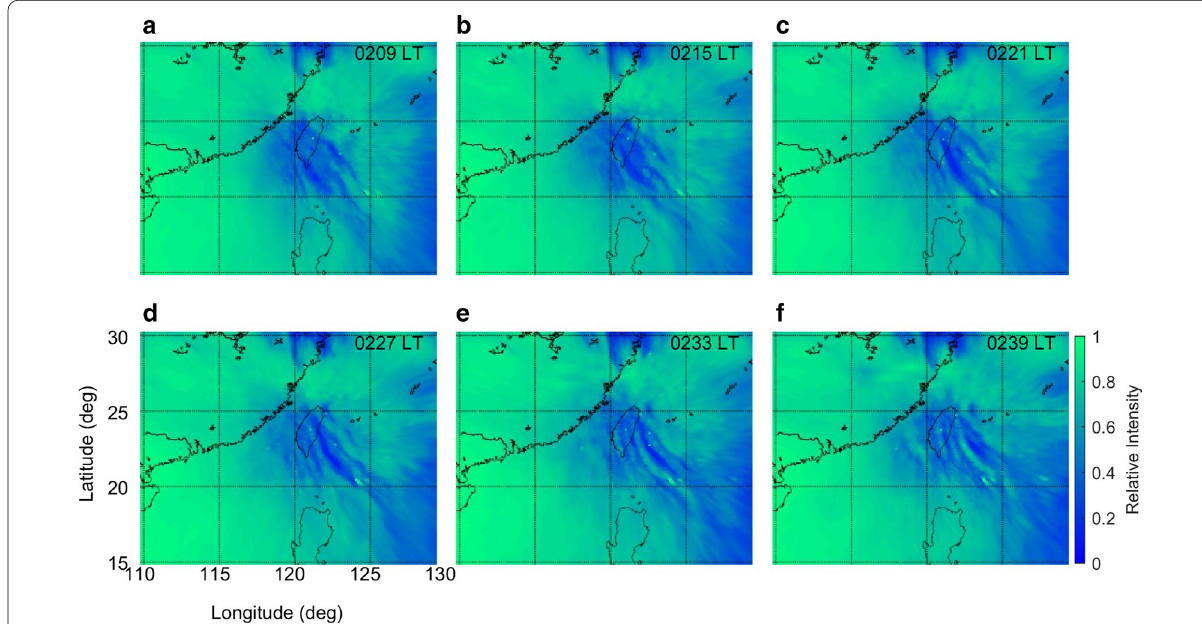
Fig. 8 The λ557 nm airglow images derived from Tainan Astronomical Education Area on 29 April